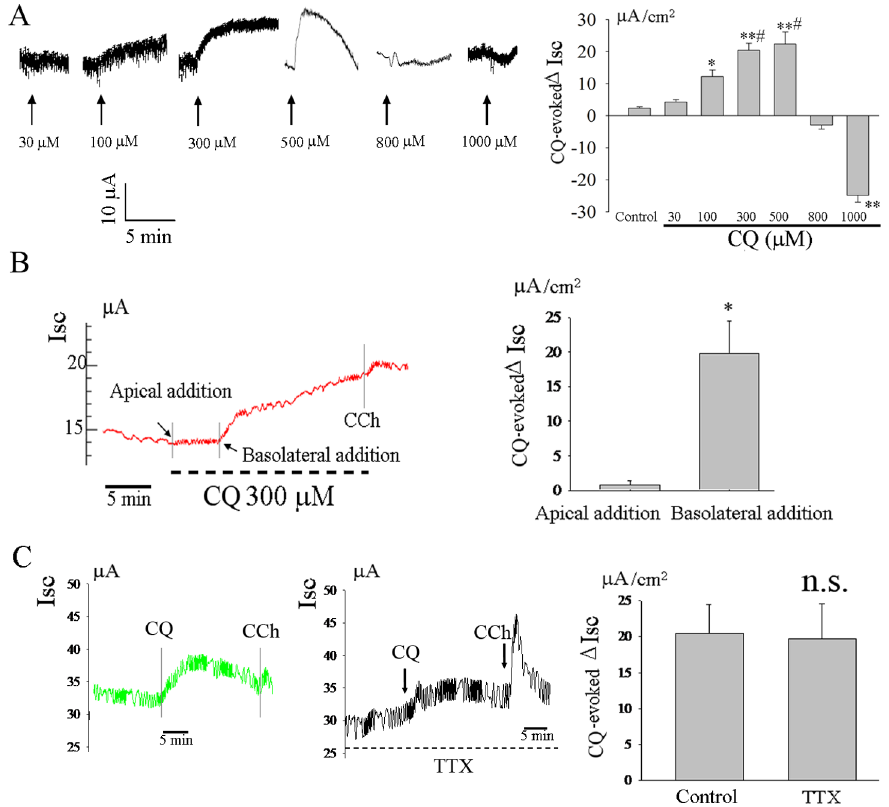
Figure 1. CQ evoked an increase in I SC in rat ileum. CQ dose-dependently increased basal I SC at low concentrations( # 5 6 10 2 4 M), however, it markedly decreased basal I SC at high concentrations ( $ 10 2 3 M) (n=6, A). The serosal addition of CQ (3 6 10 2 4 M) increased basal I SC , whereas CQ to mucosal bathing solution had no effect on basal I SC (n=6,B) . The CQ-induced increase in I SC was not influenced by TTX(n=4,C). * P , 0.05; ** P , 0.01 compared with control or apical addition; # P , 0.05 compared with 100 m M group; n.s: no significance by the one-way ANOVA or unpaired t -test.